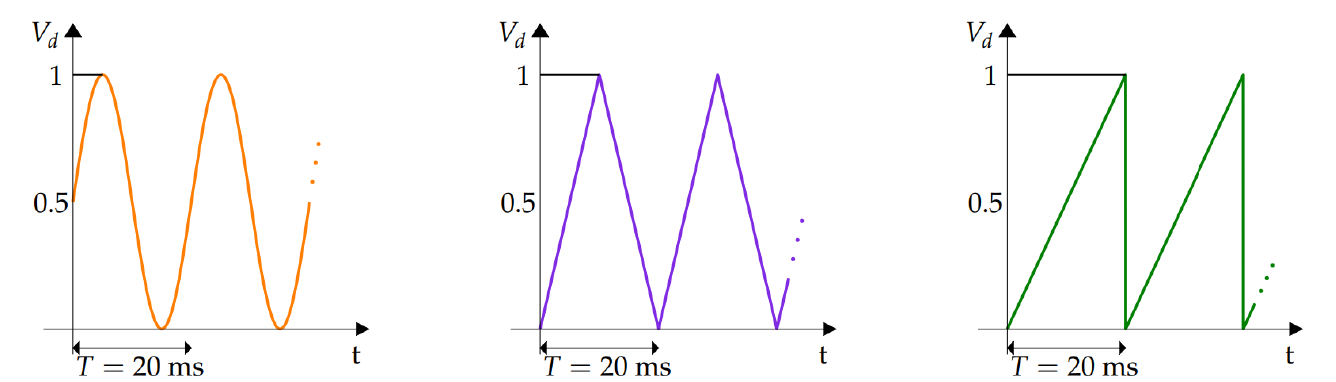
Figure 19. Desired voltage signals V d for the comparisons in Figures 20 and 21.